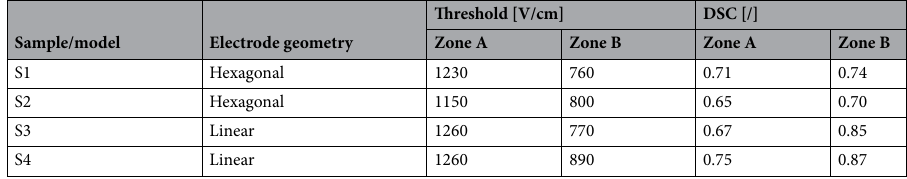
Table 1. Computed electric field threshold with the best Sørensen-Dice similarity coefficient (DSC) for Zone A (mechanical damage and coagulation necrosis) and Zone B (damage caused by